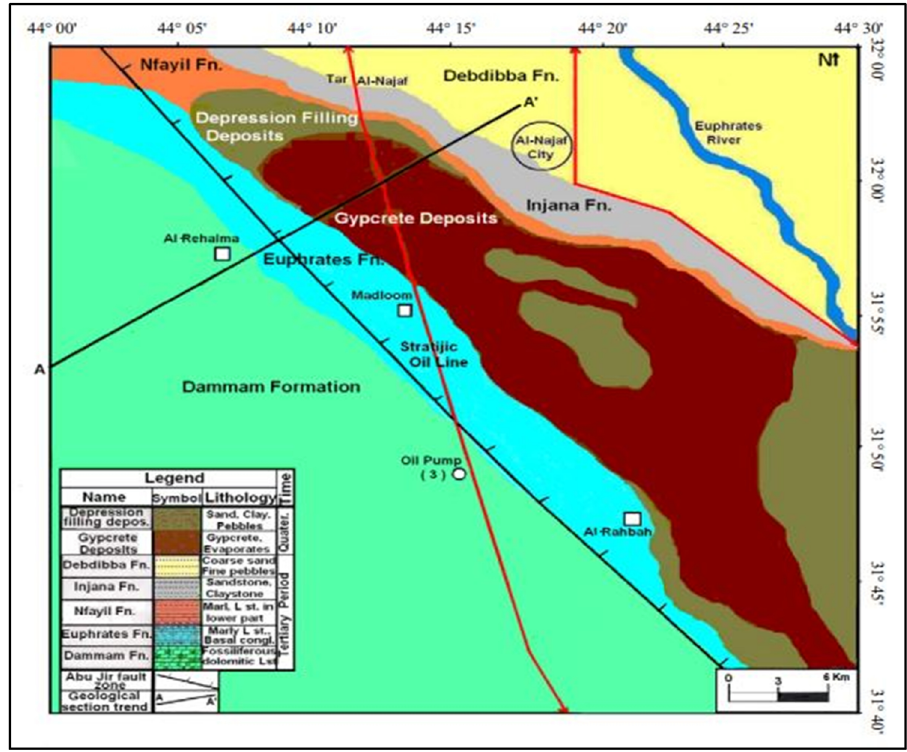
Figure 3: Geological formations in the study region and was adapted from a geological map of Al - Najaf ( NH - 38 - 2 ) compiled by Barwary and Nasira ( 1996 ) .